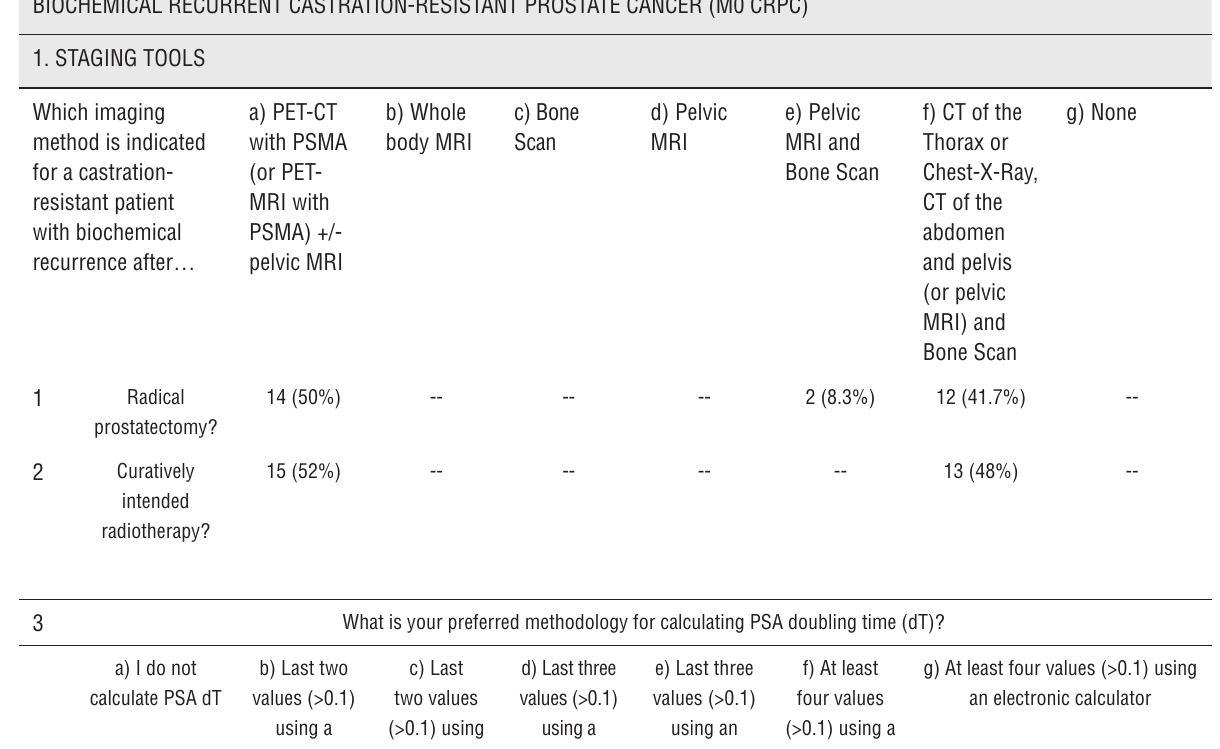
Table 1 - Survey Questions and Answer Percentages from the Consensus on Diagnosis and Management of Non-Metastatic Castration Resistant Prostate Cancer in